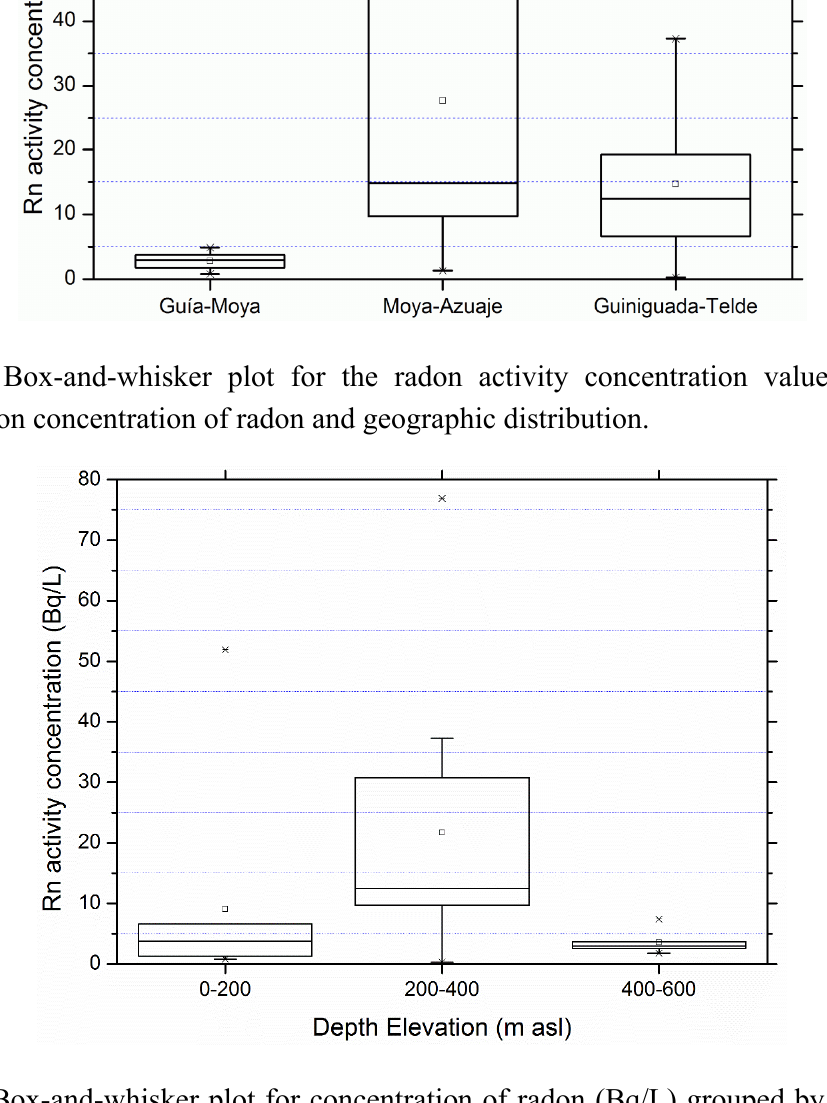
Figure 6. Box-and-whisker plot for concentration of radon (Bq/L) grouped by well depth elevation (m